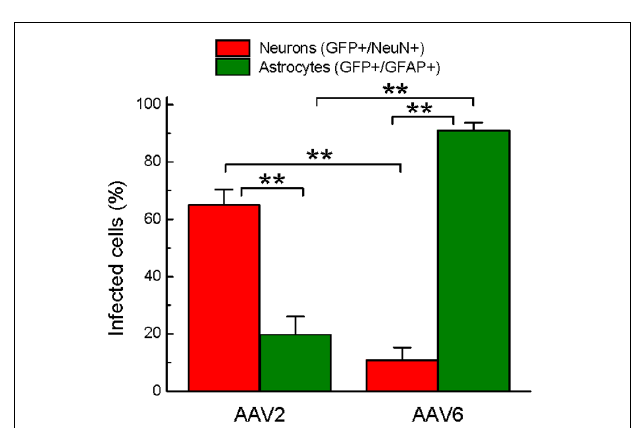
FIGURE 6 | Quantification of cell types transduced by either rAAV2 or rAAV6. The data represent blinded analysis of randomly selected stained sections from rat brains transduced with either rAAV2 or rAAV6. The data are pooled from experiments using two different virus batches and four different animals for each rAAV serotype. Colocalization of GFP and NeuN signals was considered neuronal. Colocalization of GFP and GFAP signals was defined as astrocytic. The data were analyzed by ANOVA with post hoc Tukey test for multiple corrections and are presented as the means ± SEM (a total of 25 sections, 3 + different sections per brain, from four animals per viral construct). ∗∗ p = < 0.01 between neurons and astrocytes transduced by the same serotype or between the same cell type transduced by different